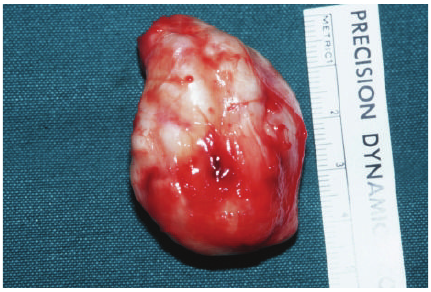
Figure 9: Macroscopic aspect of the tumorous mass in Hoffa’s fat